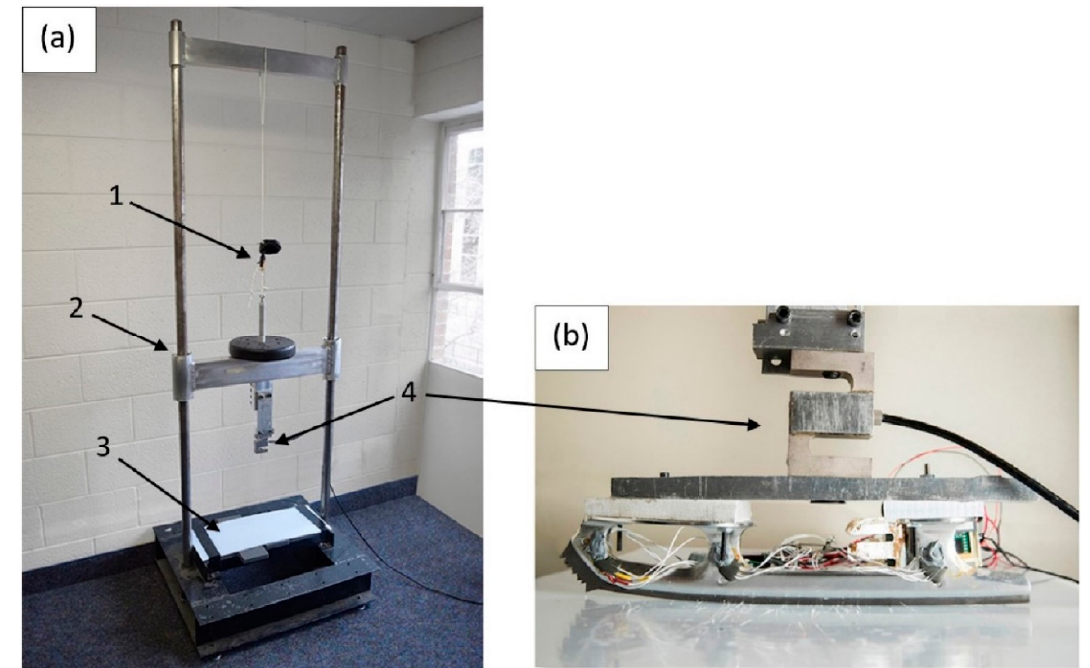
Figure 5. Load cell validation setup. To measure forces under controlled conditions, a drop tower ( a ) was used consisting of a weighted sled mounted on linear bearings (2); the sled was released from different heights using a mechanical archery caliper (1), falling onto a force plate covered by artificial ice (3). Attached to the sled was a load cell (4) and the instrumented blade ( b ).